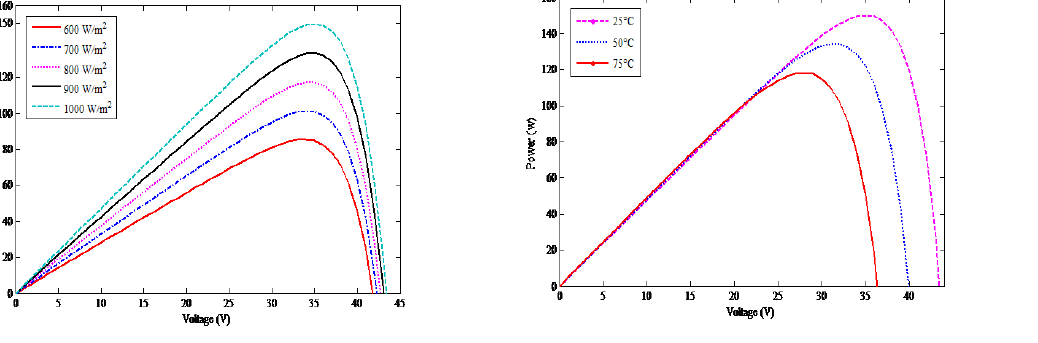
Fig. 5: P-V Characteristics under variable